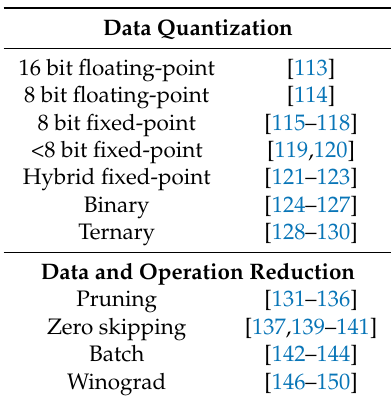
Table 4. Summary of the most used data quantization and data reduction